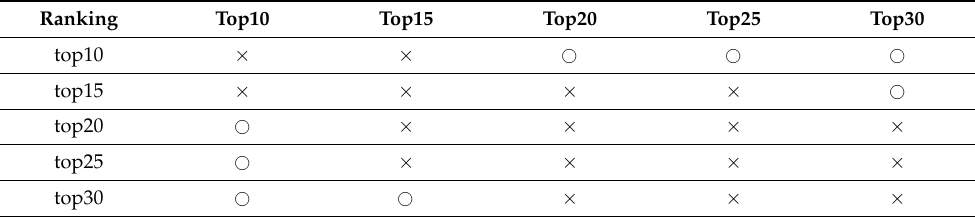
Table 4. The result when MME is taken based on the different rank of KGE. Also, it shows the differences for KGE in the validation